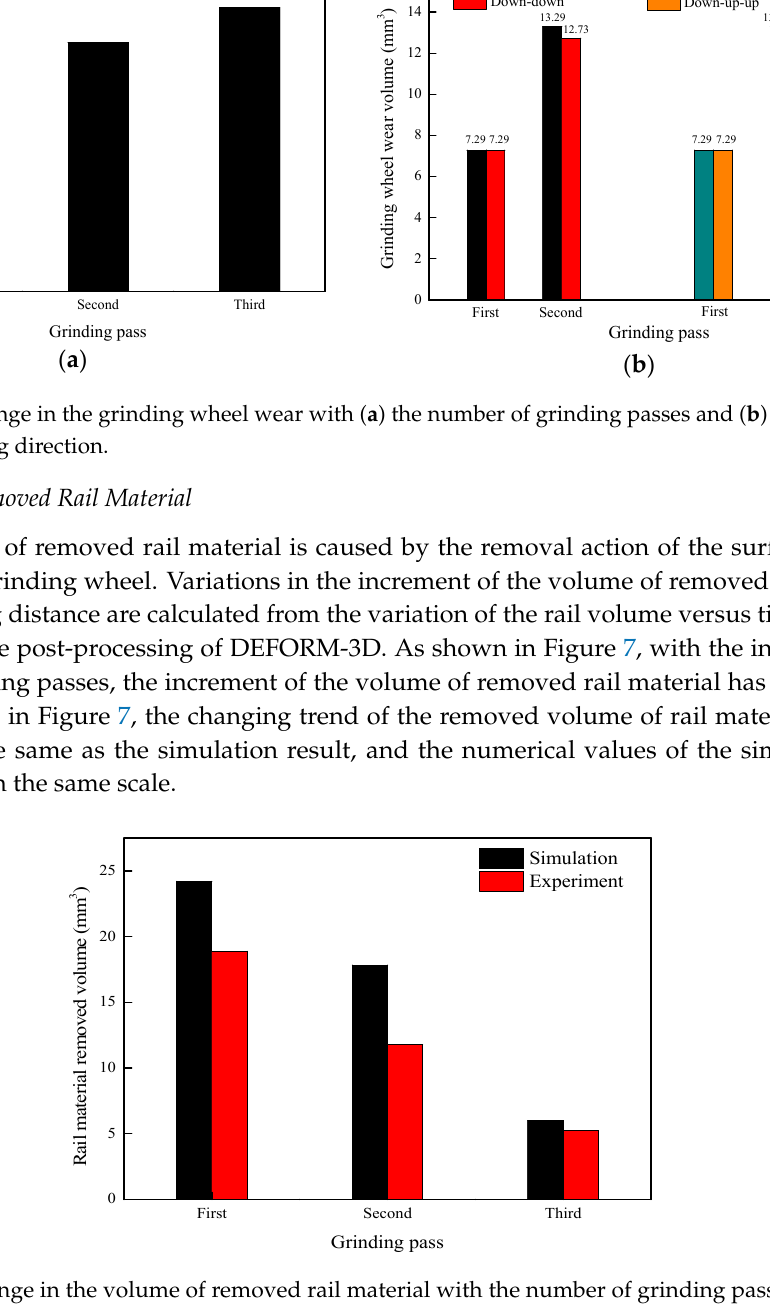
Figure 7. Change in the volume of removed rail material with the number of grinding passes in the simulation and the experiment.